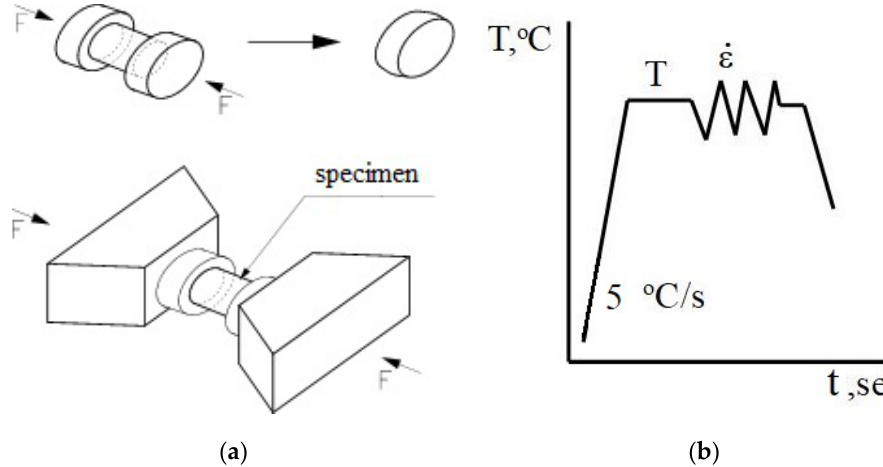
Figure 1. Geometry and dimension of load ( a ); and thermal cycle of physical simulation ( b ).